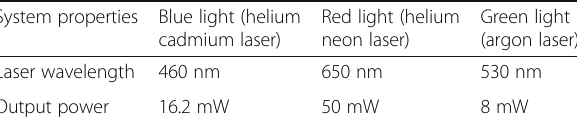
Table 1 Source of laser types used for mutagens System properties Blue light (helium cadmium laser)